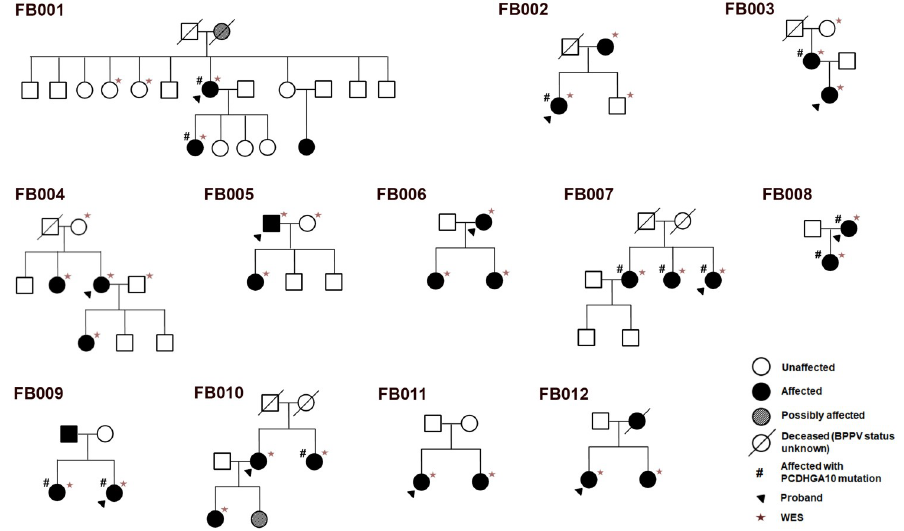
Fig 1. Pedigrees of the 12 BPPV families selected for whole exome sequencing (WES) including UTR. Filled arrowheads indicate probands. Circle and square symbols represent female and male individuals, respectively. Symbols with slashes indicate deceased individuals. The BPPV status of deceased individuals is unknown unless the circle or square is shaded or filled. Affected and unaffected family members are denoted in filled and unfilled symbols, respectively. Asterisks indicate the family members selected for WES, and # indicates those carrying the PCDHGA10 variant rs113784532. FB: Familial BPPV.